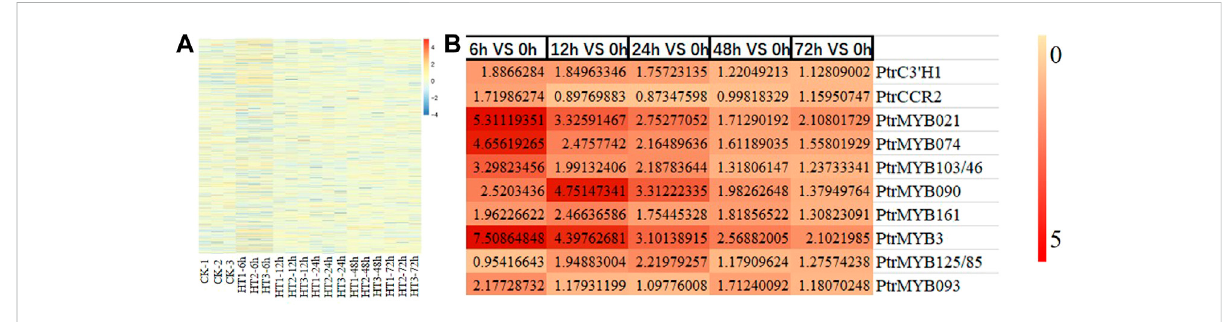
FIGURE 5 The variation trend of lignin-related genes induced by heat stress. (A) Cluster analysis of lignin-related genes induced by heat stress. (B) The expression level ofsomelignin-related genes atdifferenttime periods (6, 12,24, 48,72 h)comparedwiththecontrol group (0 h)after HTtreatment. CK is the sample of 0 h. HT means high temperature. DEG means differential expressed